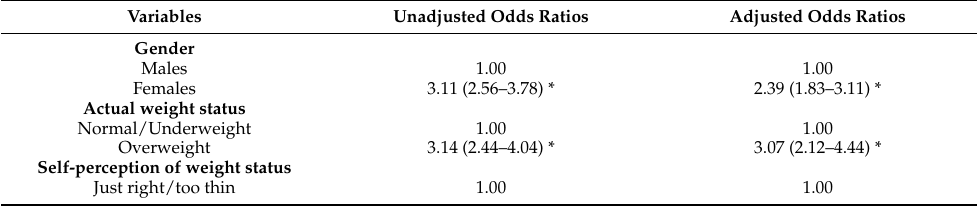
Table 6. Unadjusted and adjusted odds ratios (95% CI) of trying to lose weight by analyzed variables. Variables Unadjusted Odds Ratios Adjusted Odds